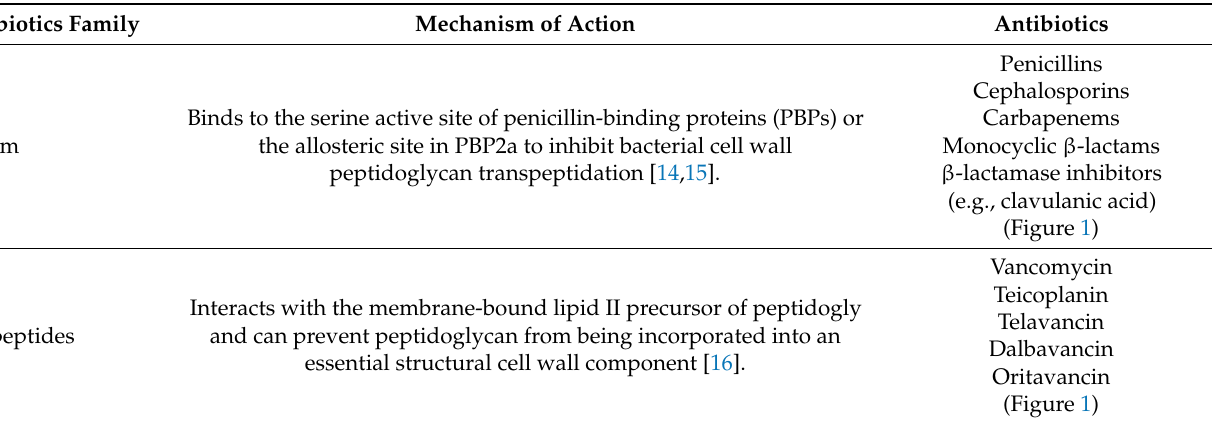
Table 1. List of antimicrobial agent and their mechanism of